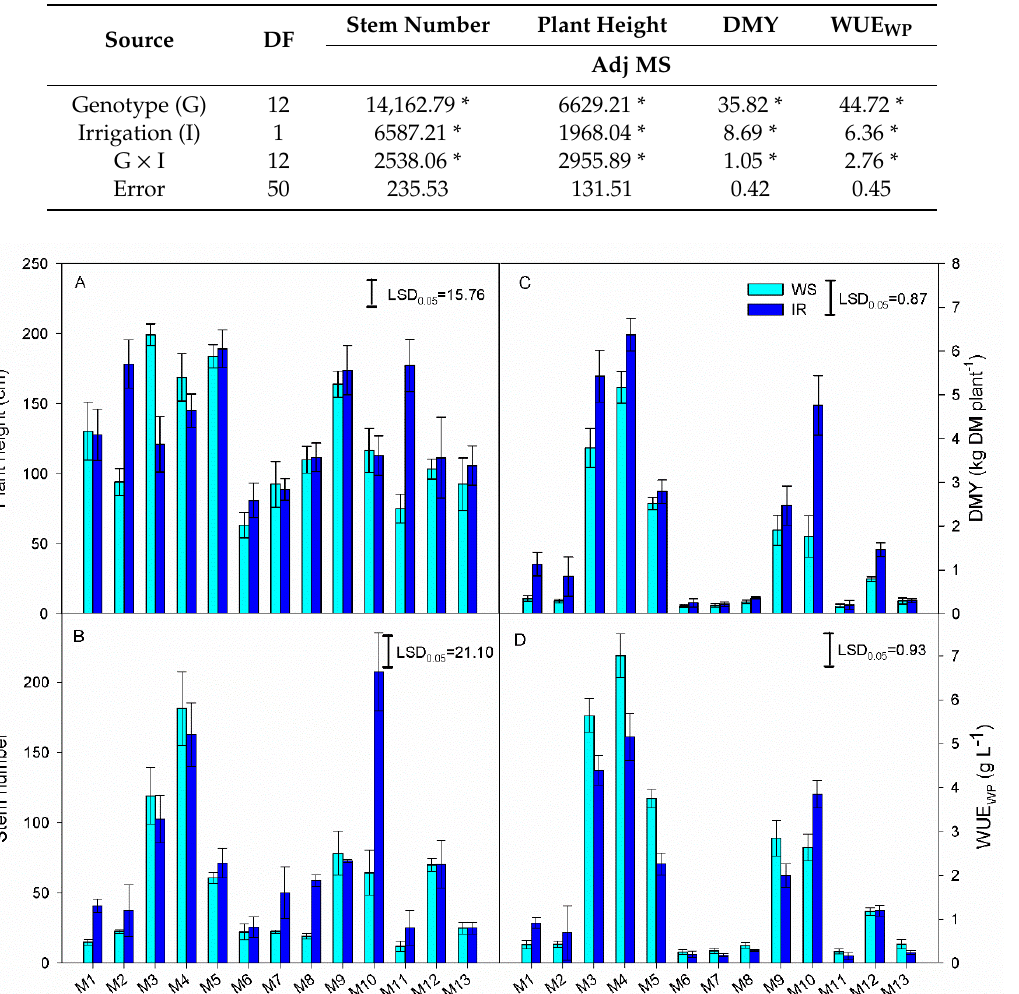
Table 2. Two-way ANOVA for main effects and interactions on morphological traits (stem number and plant height), biomass yield (DMY) and crop water use efficiency (WUE WP ). Degree of freedom (DF); adjusted mean square (Adj MS); Significance indicated by * at p ≤ 0.05.